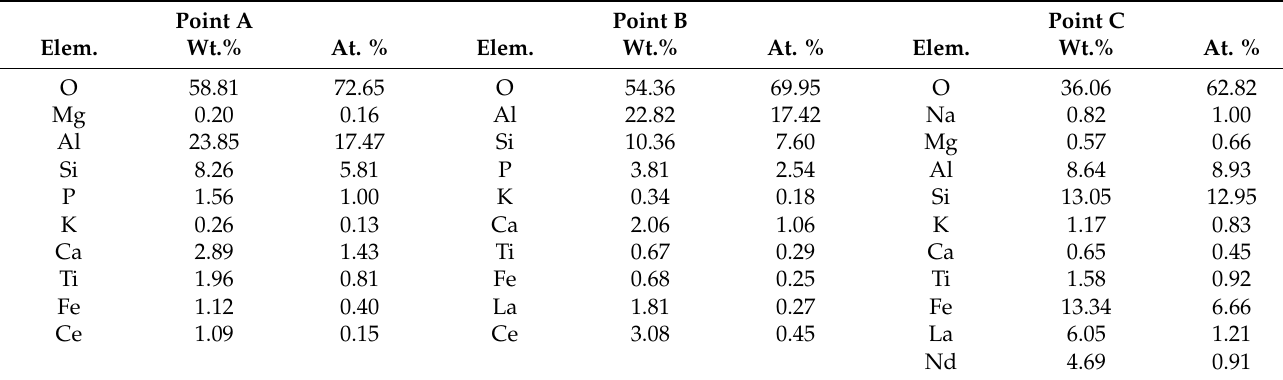
Table 4. The EDS analysis of points in Figure 7.